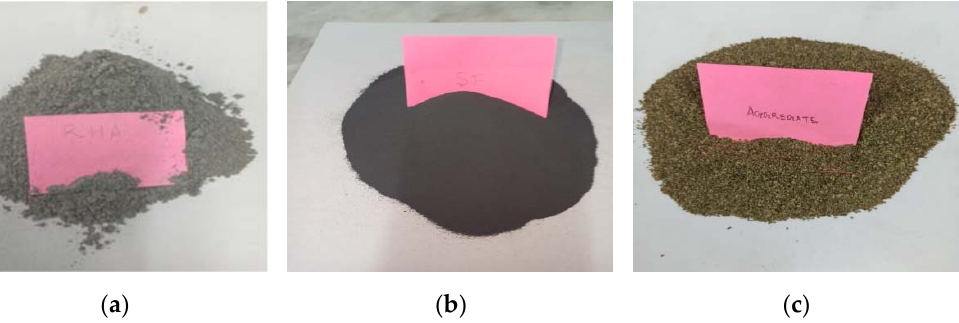
Figure 1. Physical appearance of raw material.( a ) Rice Husk Ash; ( b ) Silica Fumes; ( c ) Aggregates. Table 1. Mixture Proportion used to prepare sample.